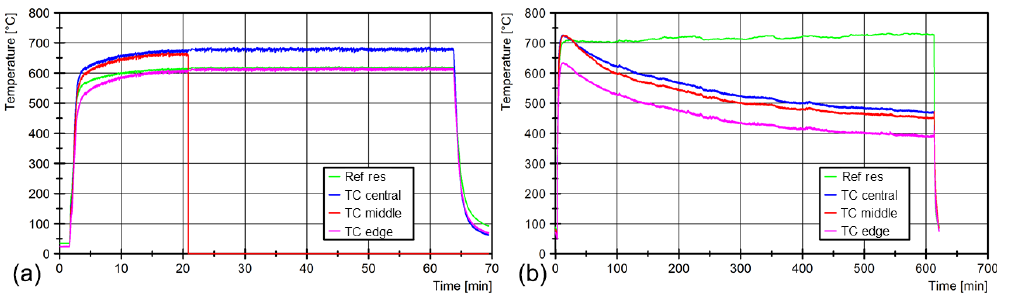
Figure 7. Long-term investigation of sensors in hot-air test rig at high temperature and mechanical stress caused by shaking (a) material combination Pt-PtRh 10 and (b) material combination